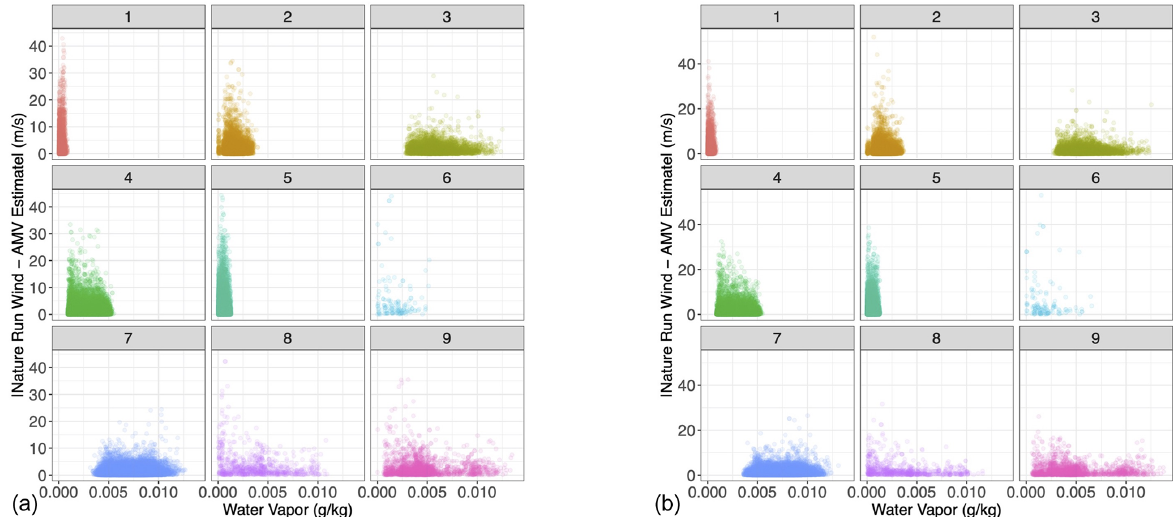
Figure 7. Scatterplot of water vapor vs. absolute tracked wind error, each sub-panel corresponding to the specific Gaussian mixture compo- nent to which each point in the testing set has been assigned. (a) u -direction wind; (b) v -direction